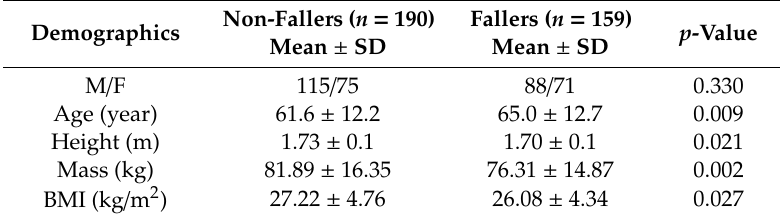
Table 1. Demographic characteristics of study